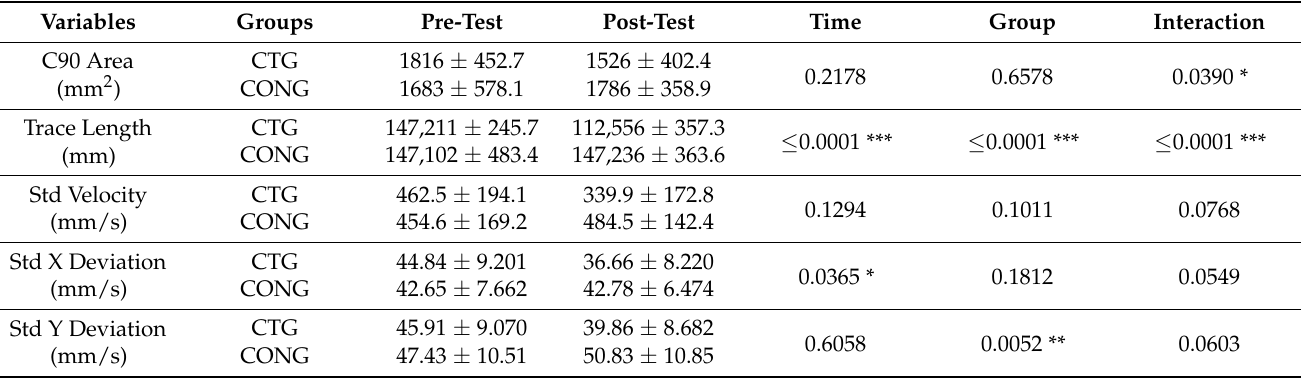
Table note: CTG (n = 20), CONG (n = 20), * means p ≤ 0.05, ** means p ≤ 0.01, *** means p ≤